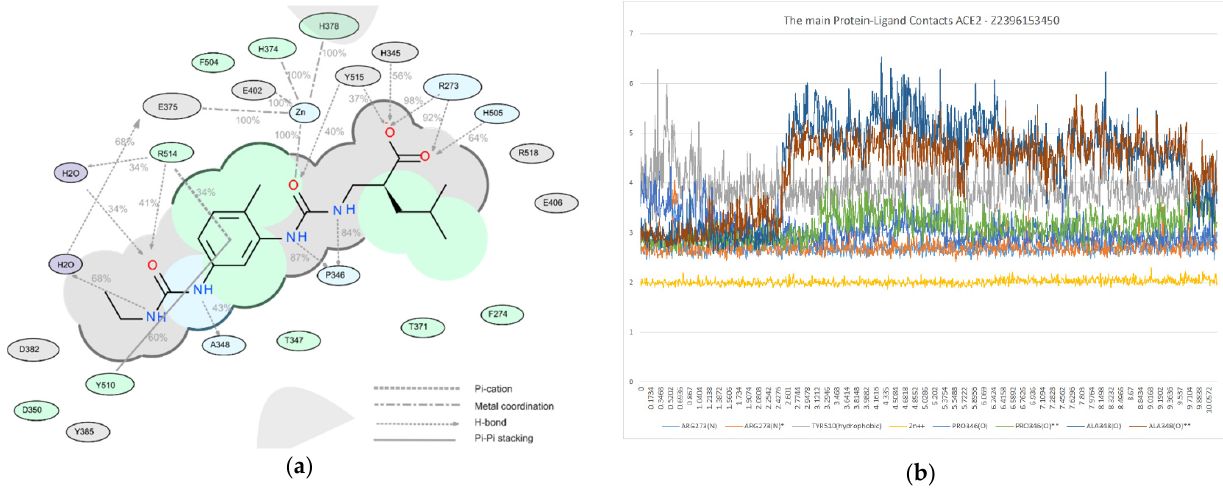
Figure 12. A detailed interaction scheme of ligand atoms (Z3969355209) with protein residues: ( a ) generalized graphical representation of the interactions and contacts (H-bonds, hydrophobic, ionic, water bridges); ( b ) scheme showing the distance evolution (in Å) between the ligand and residues.